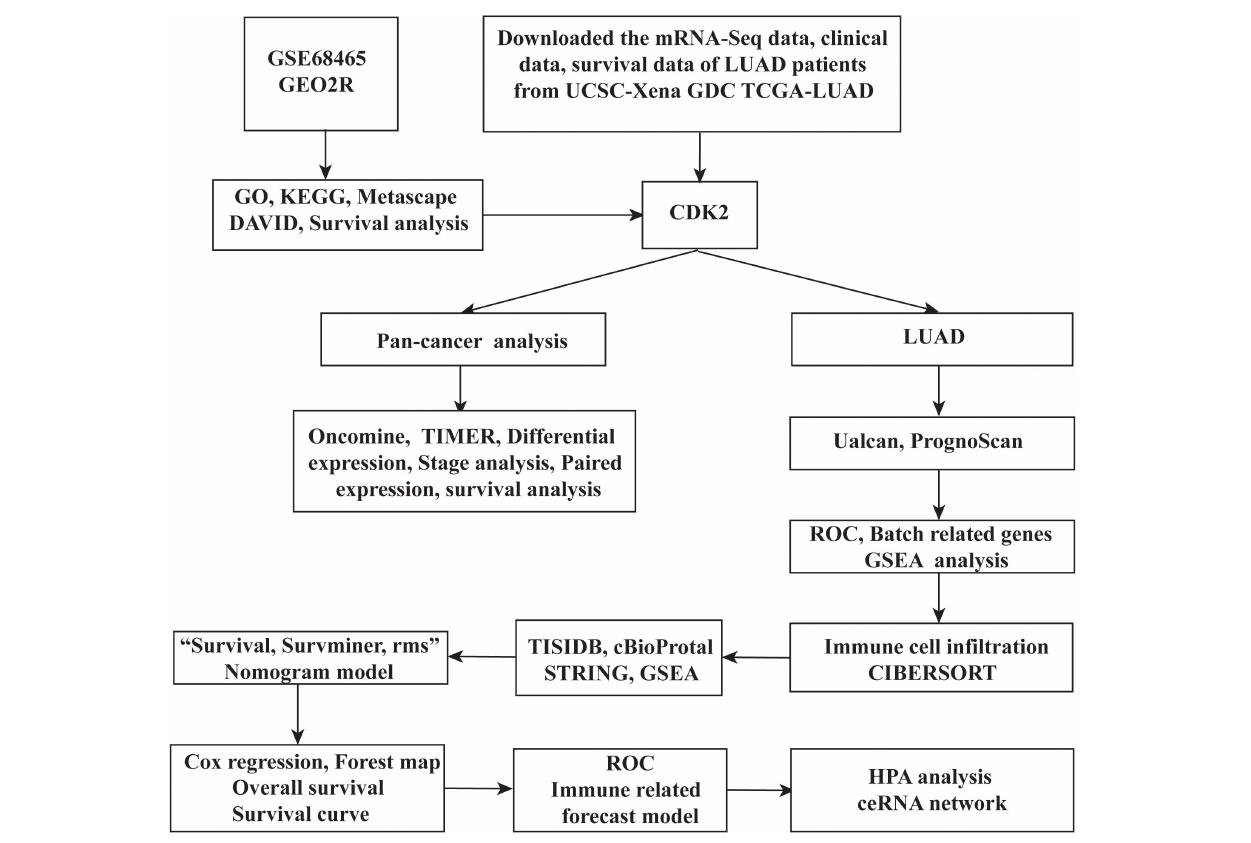
FIGURE 1 | The overall research ideas of this paper were shown as follows.